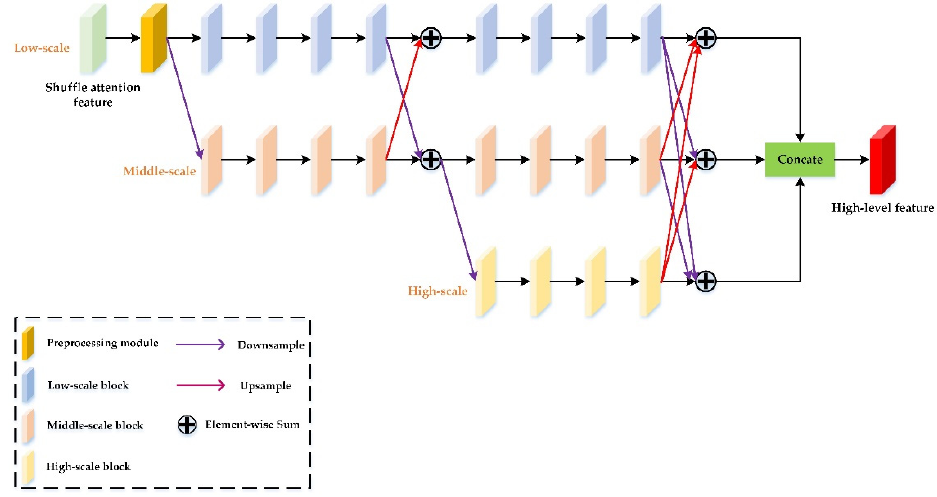
Figure 3. The schematic diagram of CHSFEM.